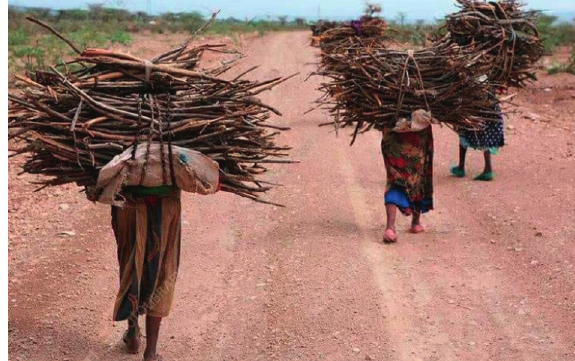
Figure 5: Effect of energy poverty in rural community in Ethiopia.